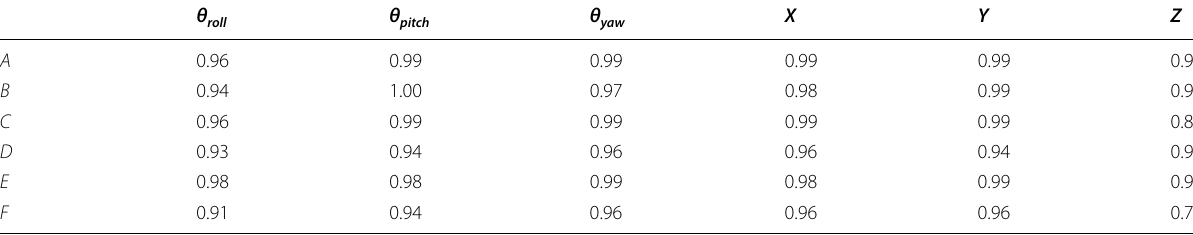
Table 3 Correlation coefficient between measuring and